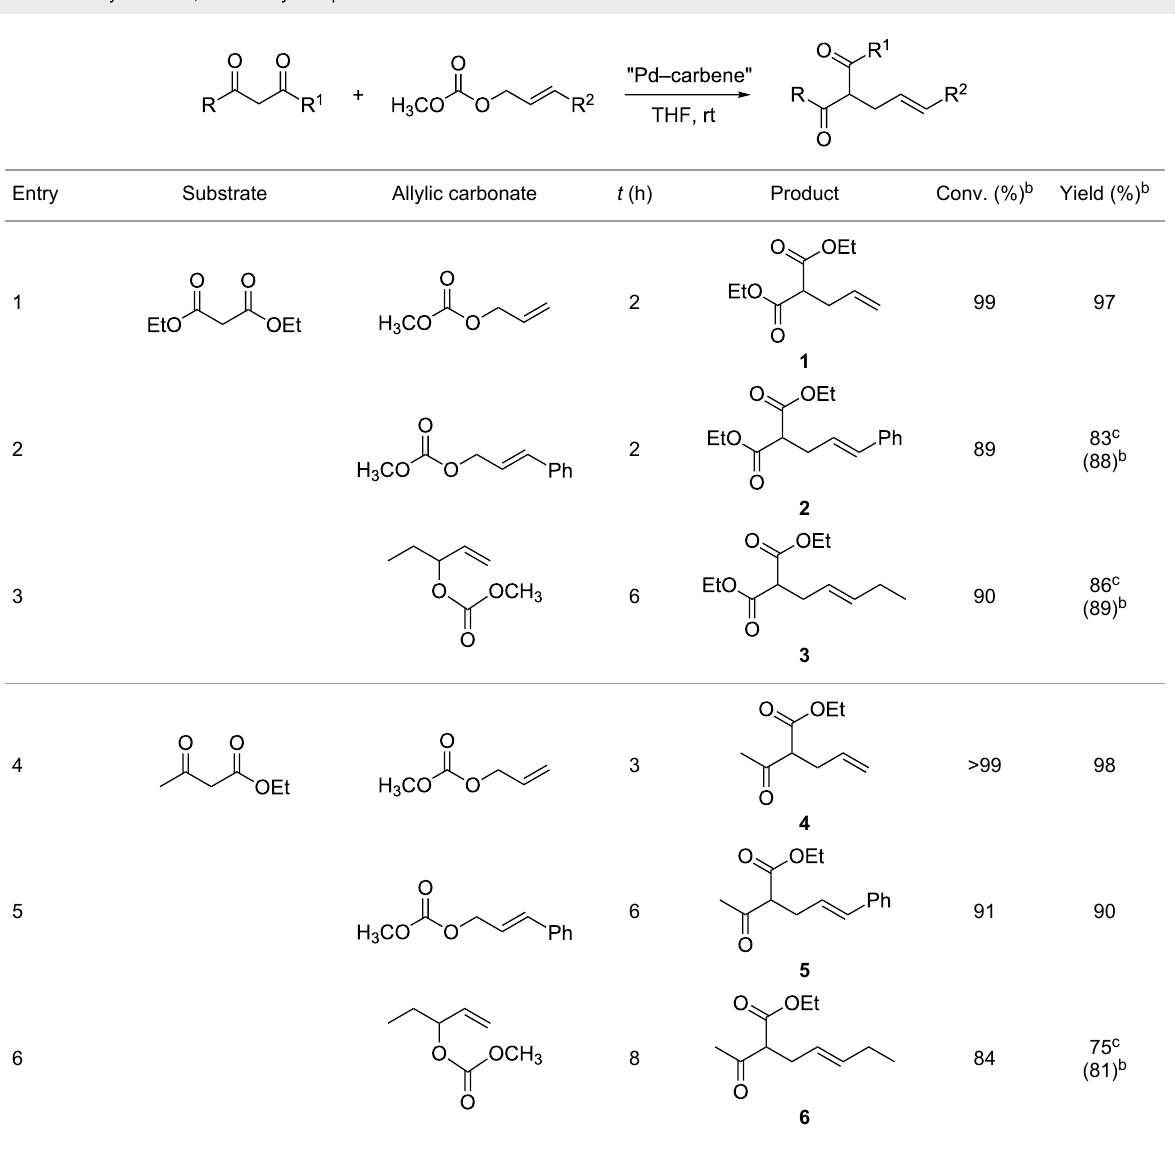
Table 2: α -allylation of 1,3-dicarbonyl compounds a .